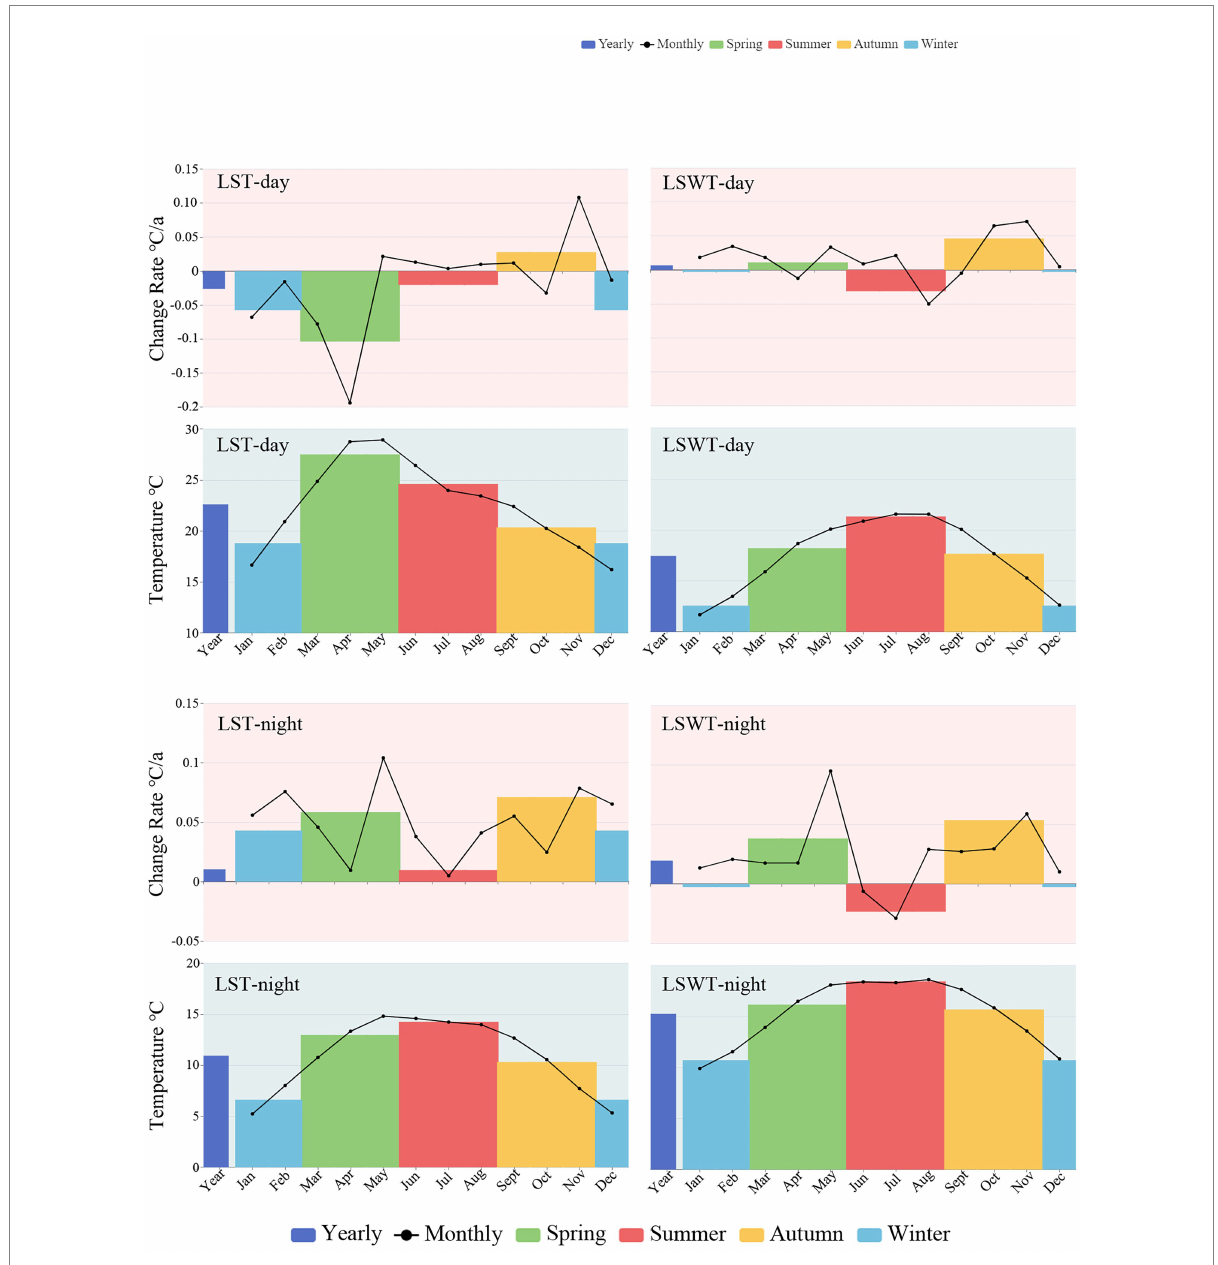
FIGURE 8 Multiscale average temperature and trend from 2001 to